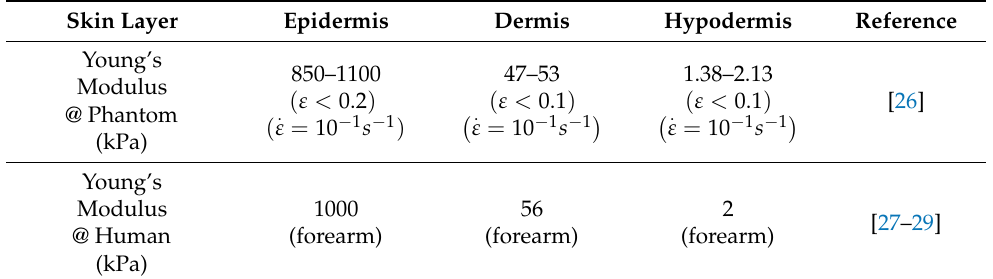
Table 3. Young’s modulus for each layer of the simple flow phantom and human Table 3. Young's modulus for each layer of the simple flow phantom and human skin.